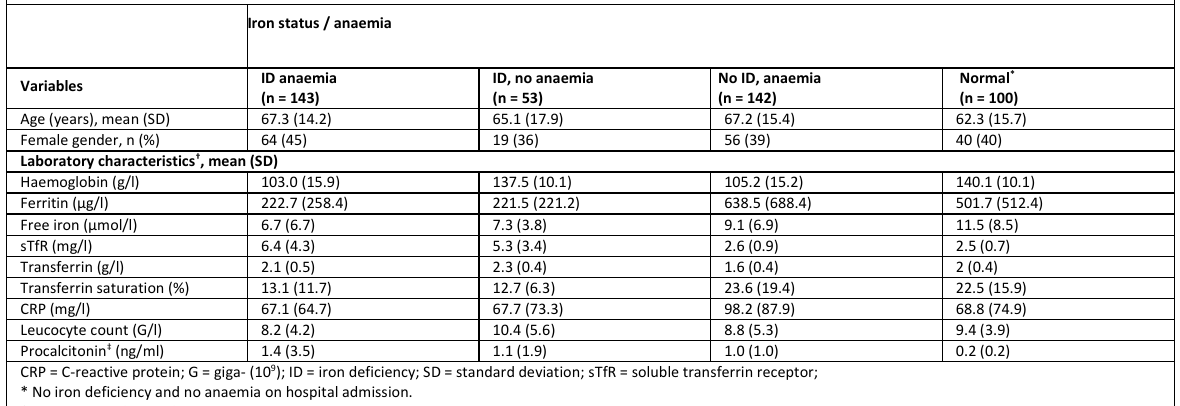
Table 1: Demographic and laboratory data stratified by iron status and presence of anaemia on hospital admission (number of patients = 438). Iron status / anaemia